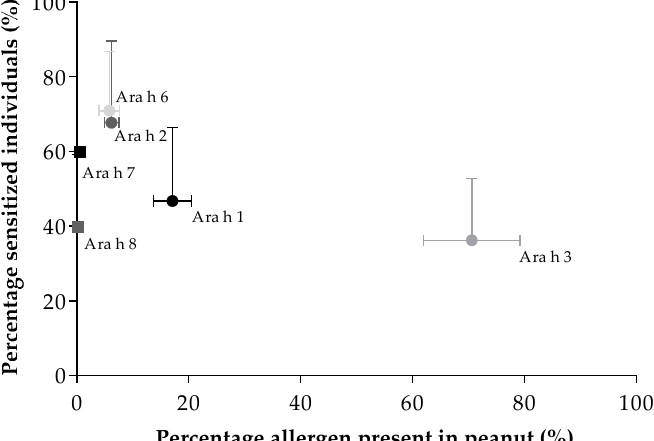
Figure 4. Relation between percentage of peanut sensitized individuals and percentage of peanut allergen in total peanut. The standard deviations are indicated by the horizontal (protein content) and vertical (allergen sensitization) error bars. A nonsignificant ( p > 0.05) correlation ( r = − 0.257) was found between mean peanut content and mean allergen sensitization.